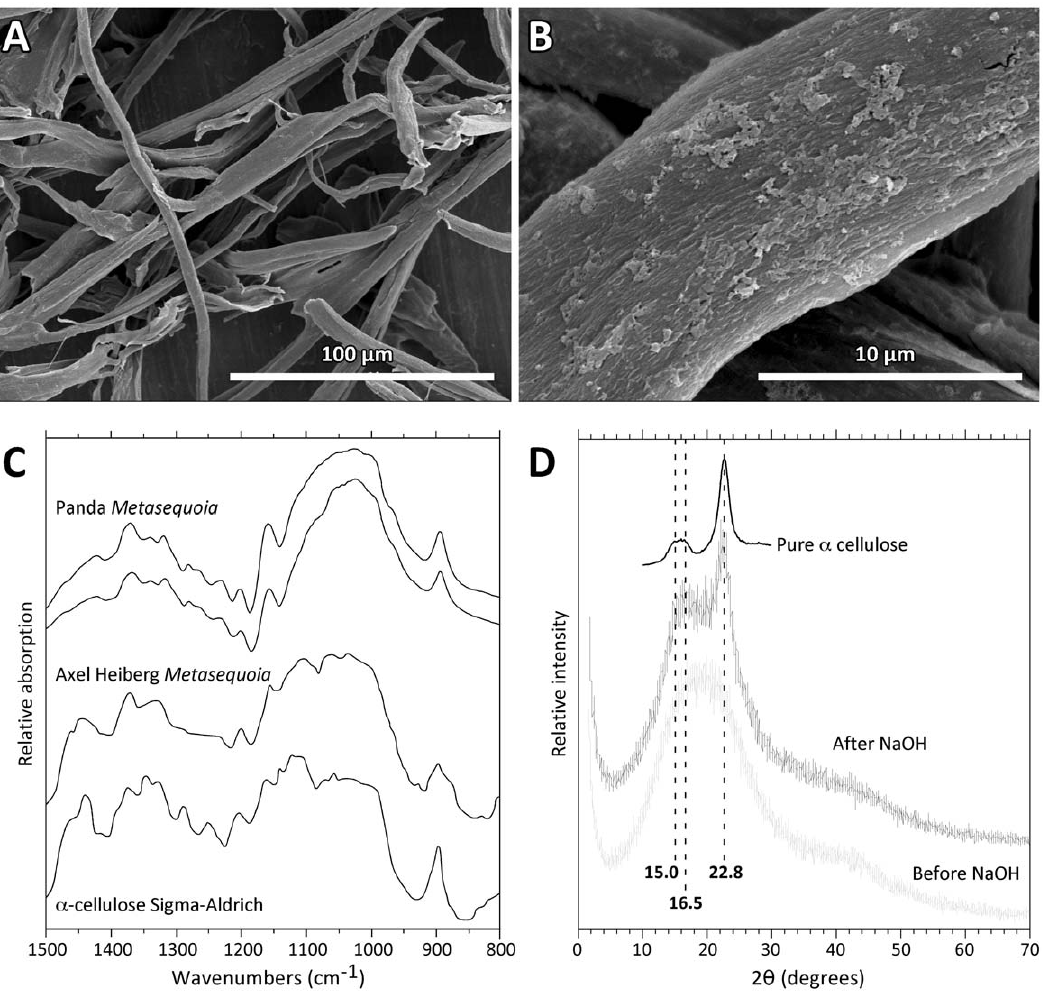
Figure 2. Cellulose extracted from Panda Metasequoia . A. SEM of cellulose fibers at low magnification. B. SEM at higher magnification showing surface texture. C. Duplicate FTIR spectra (800–1500 cm 2 1 ) of the same material, shown in relation to Middle Eocene cellulose from Axel Heiberg Island Metasequoia [15] and laboratory standard (Sigma-Aldrich) a -cellulose. D. X-ray diffraction traces of Panda cellulose extracts before (grey) and after (black) treatment with NaOH. Peaks associated with a -cellulose crystallinity are indicated by vertical dashed lines, whereas the idealized spectrum of pure a -cellulose is shown above the Panda traces [17].